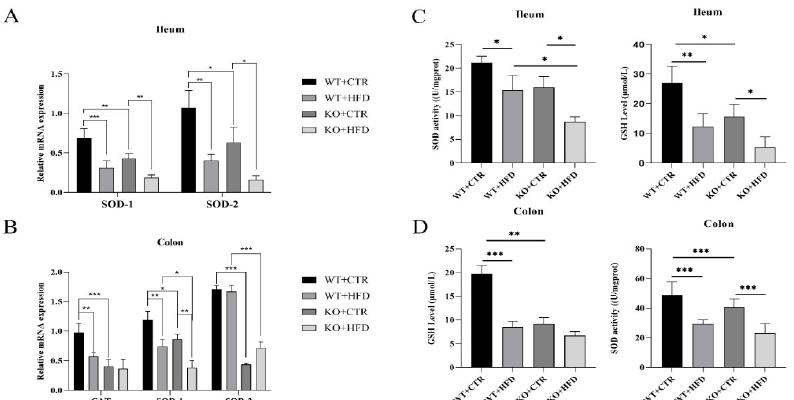
Figure 4. TRIM67 knockout mice represent suppressed antioxidant capacity in ileum and colon. ( A ) The mRNA expression of SOD ‐ 1 ( n = 4) and SOD ‐ 2 ( n = 4) in ileum. ( B ) Relative mRNA expression of CAT ( n = 4), SOD ‐ 1 ( n = 4) and SOD ‐ 2 ( n = 5) in colon. ( C , D ) SOD activity and GSH level in ileum and colon to check the antioxidant activity ( n = 8). The data are expressed as mean ± SEM. Significance was determined by one ‐ way ANOVA (* p < 0.05, ** p < 0.01, *** p < 0.001).